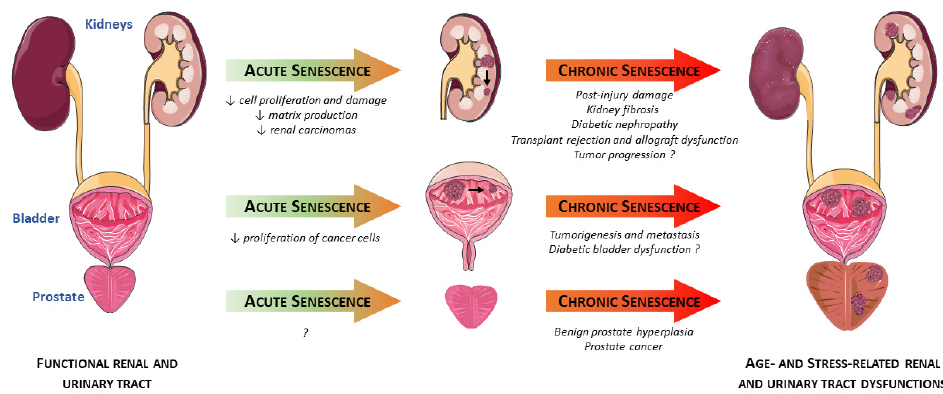
Figure 2. Potential roles of senescent cells in renal and urinary tract disorders. Cellular senescence plays major but intricate roles in the progression of renal and urogenital disorders including kidney, prostate, and bladder dysfunction. While transient senescence appears to be beneficial in acute pathological conditions, chronic senescence hastens urogenital alterations. Senescent cell accumulation is linked to various deleterious conditions like kidney damage and fibrosis, transplant rejection, or benign prostate hyperplasia. Of particular importance, the release of pro-inflammatory and pro-fibrotic mediators by senescent cells is a powerful driver of tumor progression in the bladder and the prostate.